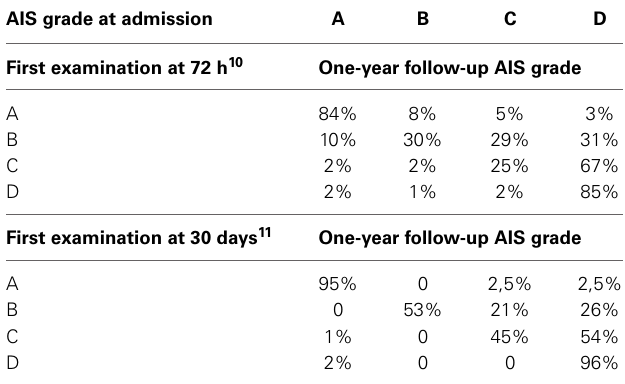
Table 1 | Prediction of recovery according to AIS impairment